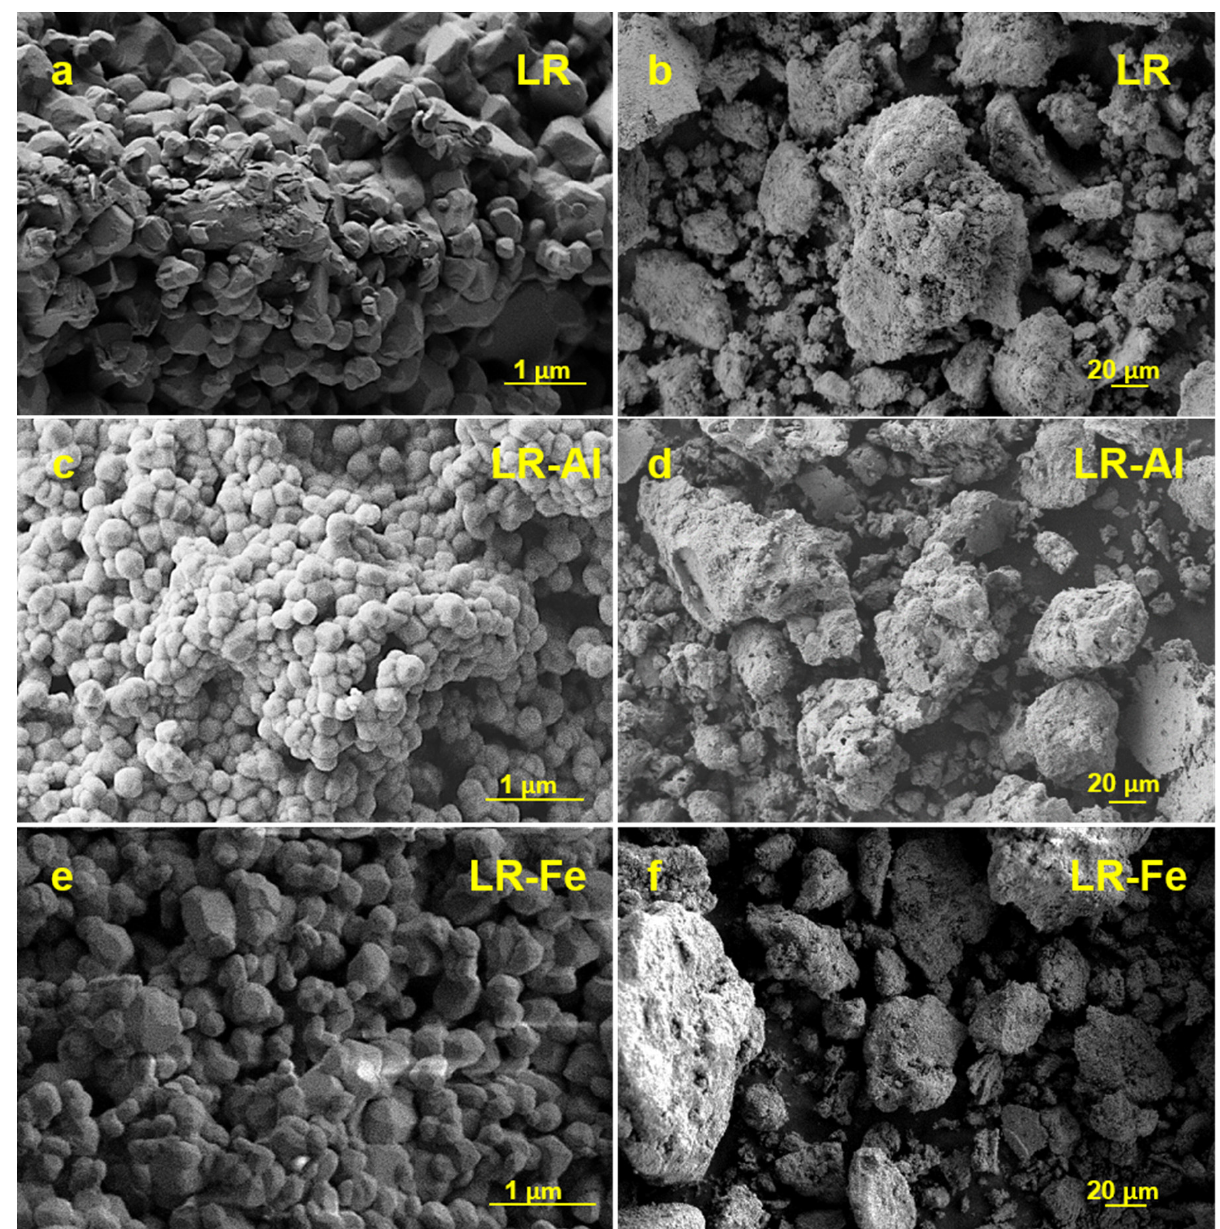
Figure 1. SEM images of the ( a , b ) LR; ( c , d ) LR-Al; and ( e , f ) LR-Fe materials.